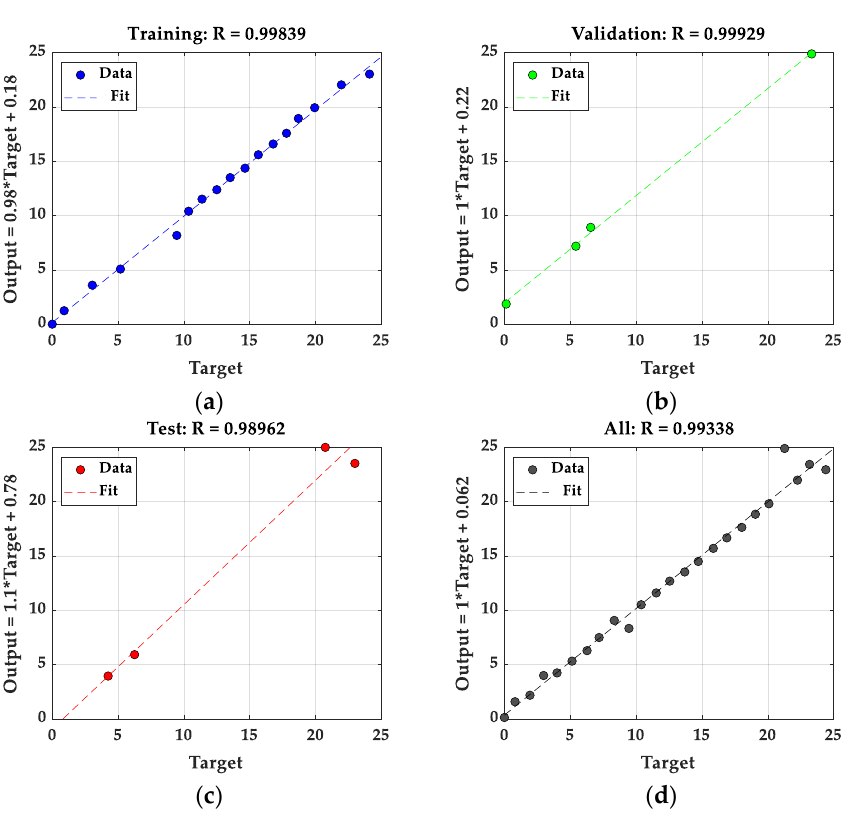
Figure 10. ANN training regression trend: ( a ) training; ( b ) autovalidation; ( c ) test with external data; ( d ) results combination(MathWorks ® , Natick, MA, USA) [32].